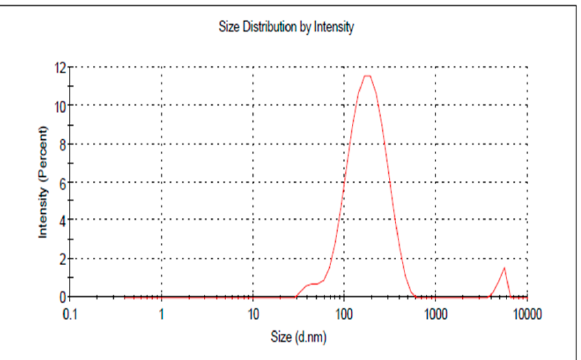
Figure 6. Particle size of optimized PGZ-loaded NE formulation.